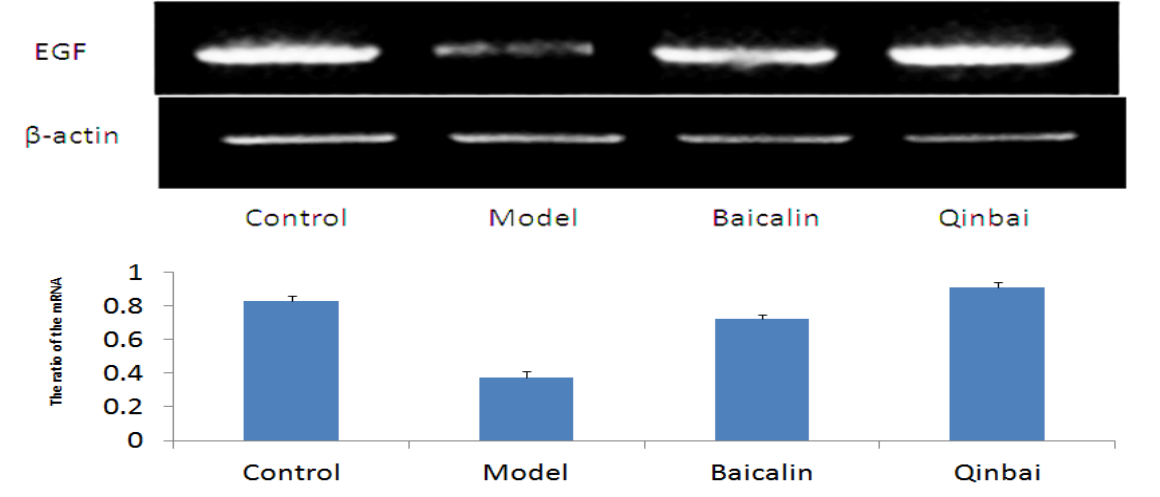
Figure 8. We performed reverse transcription-PCR to analyze the levels of EGF mRNA. After A549 cells were infected with M. pneumoniae for 4 h, cells were treated with 16 μg/mL of Baicalin and 100 μg/mL of Qinbai for 3 days at 37 °C. EGF expression in A549 cells was increased by Baicalin and Qinbai. Data are presented as mean ± SD, p <